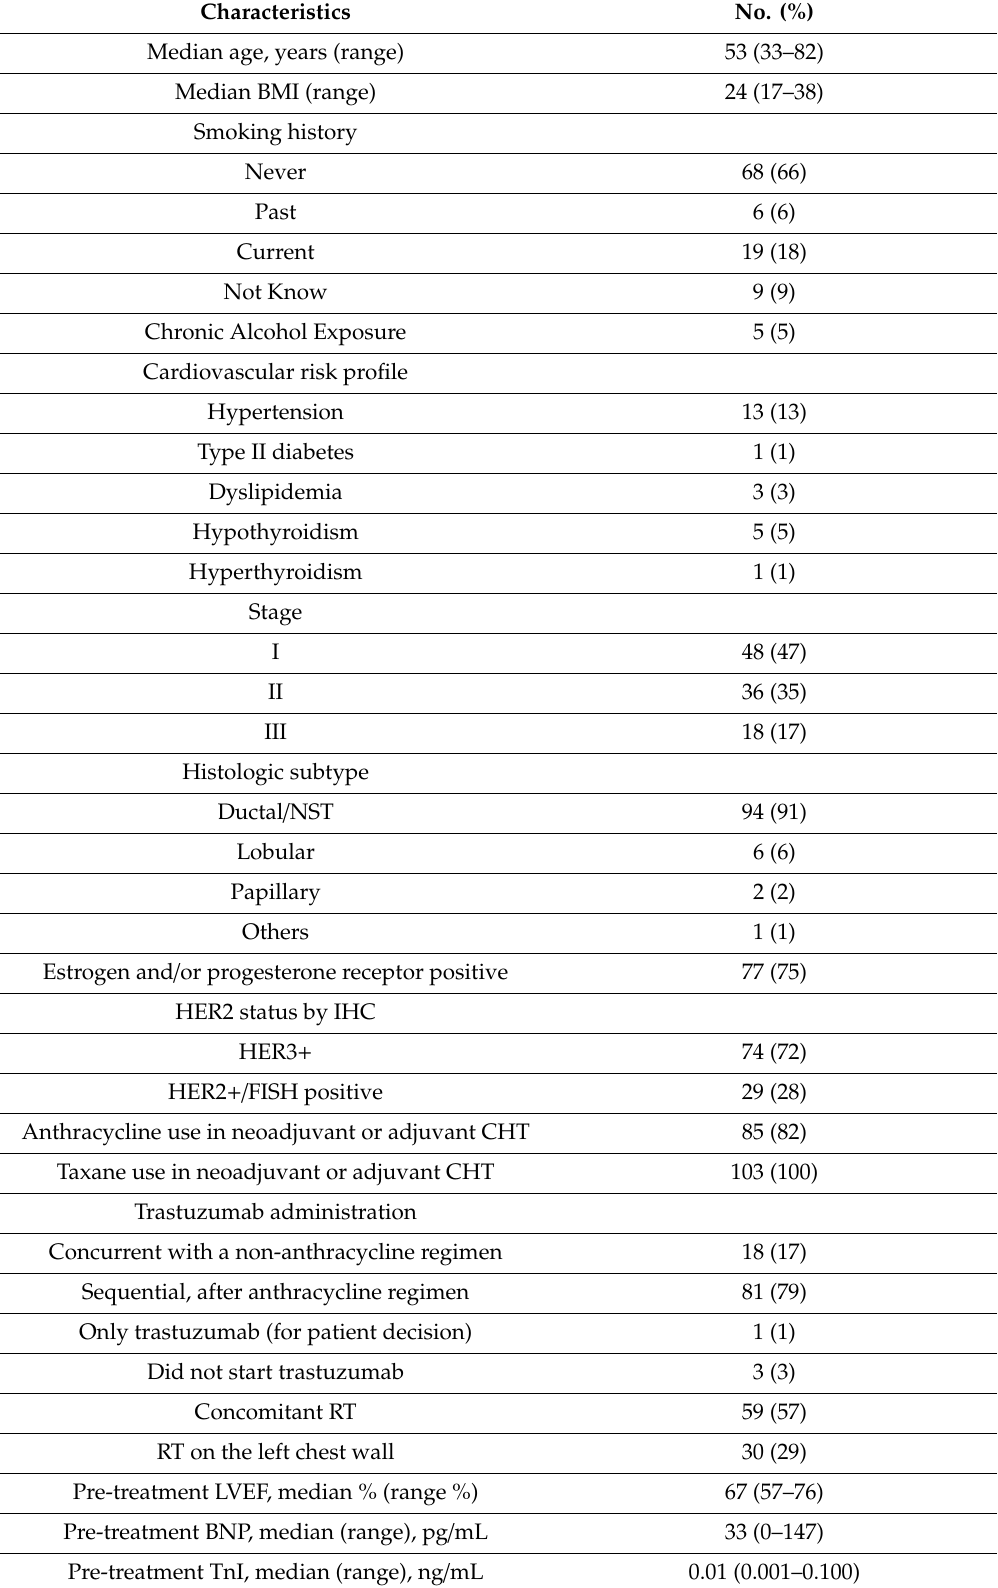
Table 1. Baseline demographics and tumor characteristics for the study